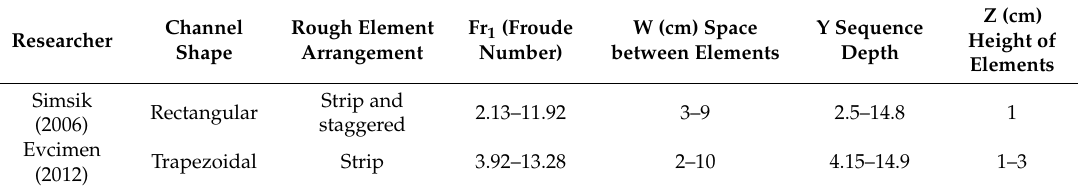
Table 1. The experimental data used in the